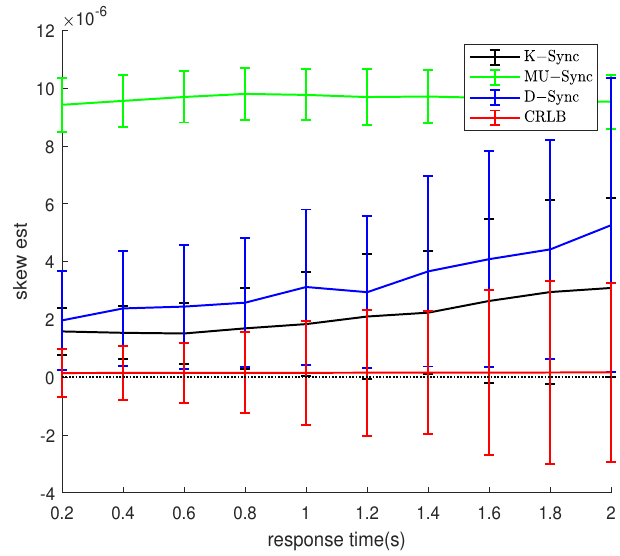
Figure 8. Performance with response time (Model 2).